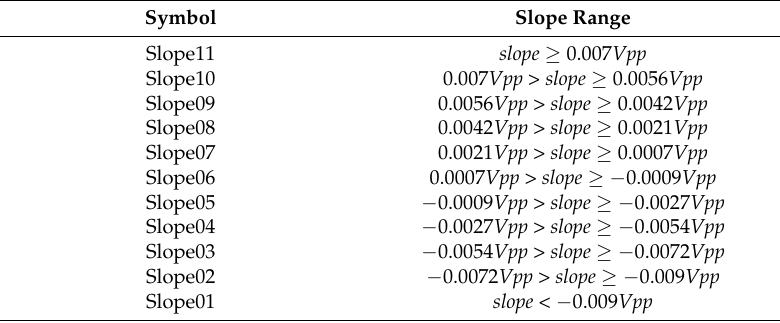
Table 1. Slope ranges used to vectorize the ECG data points.